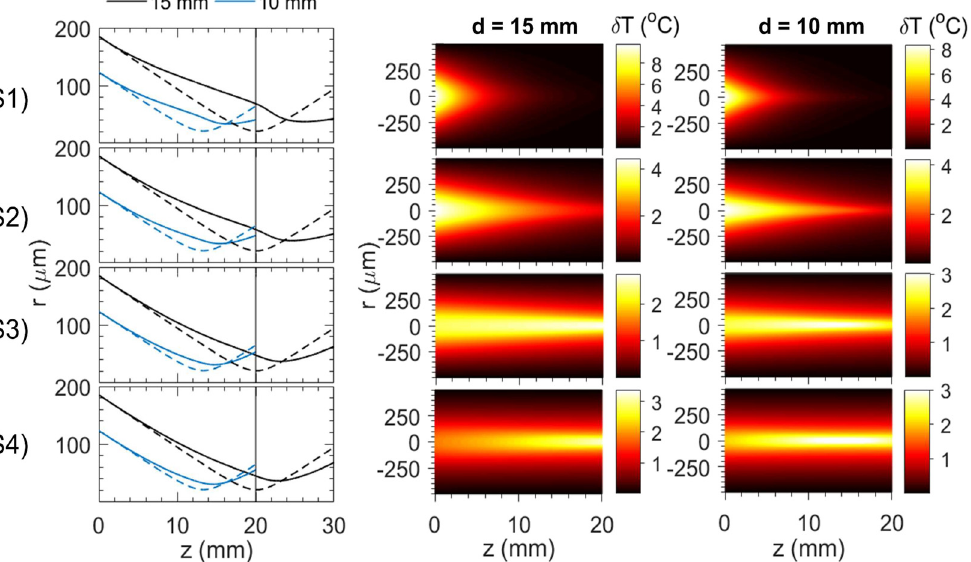
Figure9: Numericalsimulationresultsat P = P 0 for(S1) a = 2 . 10,(S2) a = 0 . 84 , (S3) a = 0 . 24and(S4) a = 0 . 06 cm − 1 . Firstcolumnshowsthe σ 2 beam width as a function of z for d = 15 mm (black lines) and 10 mm (blue lines). The dashed lines correspond to the linear case (low input power ∼ 0 . 1 mW). The second and third column show the calculated spatial temperature pro fi les at P = P 0 for d = 15 mm and 10 mm,